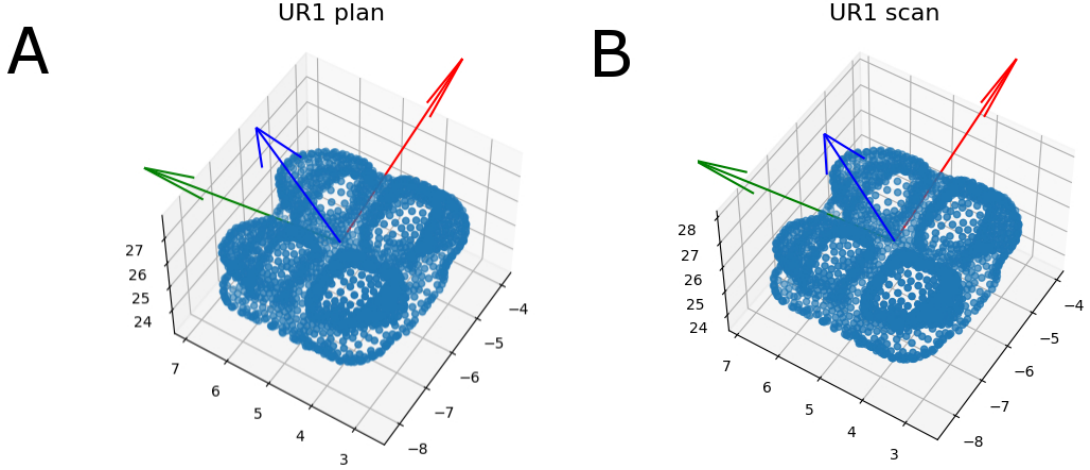
Figure 6. ( A ) Planned and ( B ) scanned bracket cloud of points representing the three-dimensional position of bracket 3.2. Blue points represent the vertices of the tessellations of equilateral triangles.